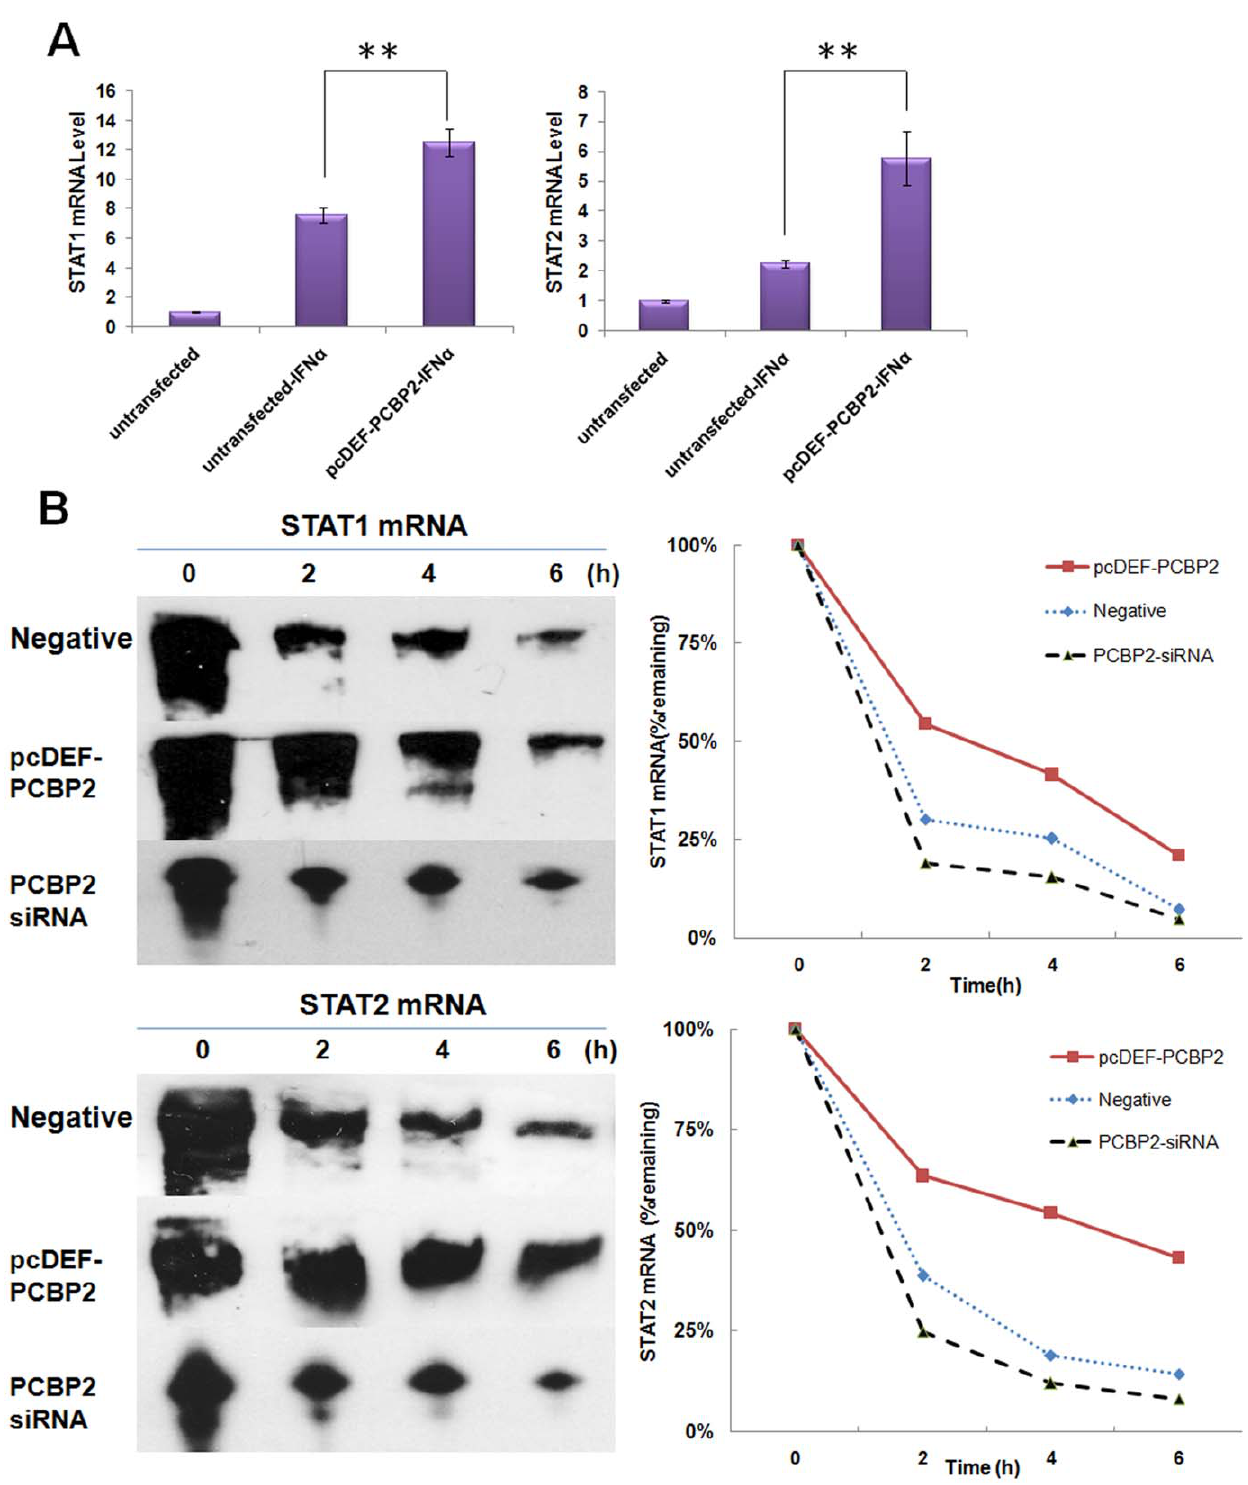
Figure 6. The STAT1 and STAT2 mRNA is stabilized in cells overexpressing PCBP2. (A) qRT-PCR was carried out to measure mRNA level of STAT1 and STAT2 after 6 hours of IFN- a treatment. R1b cells were untransfected or transfected with pcDEF-PCBP2. Each bar represents the average of triplicate data points with the standard deviation represented as the error bar . ** P , 0.001 versus untransfection. (B) RPA and RNA half-life analysis was performed to monitor the STAT1 and STAT2 mRNA decay course. Two days after transfection, IFN- a was added and 6 hours later actinomycin D was added to inhibit transcription. Representative blots are shown in the left panel and the mRNA levels were quantified through densitometric scanning. For each set of RPAs, the band intensity at the 0 h time point was set to 100%, and the percentage of mRNA of remaining at the 2, 4 and 6 hour time point was plotted shown in the right panel.